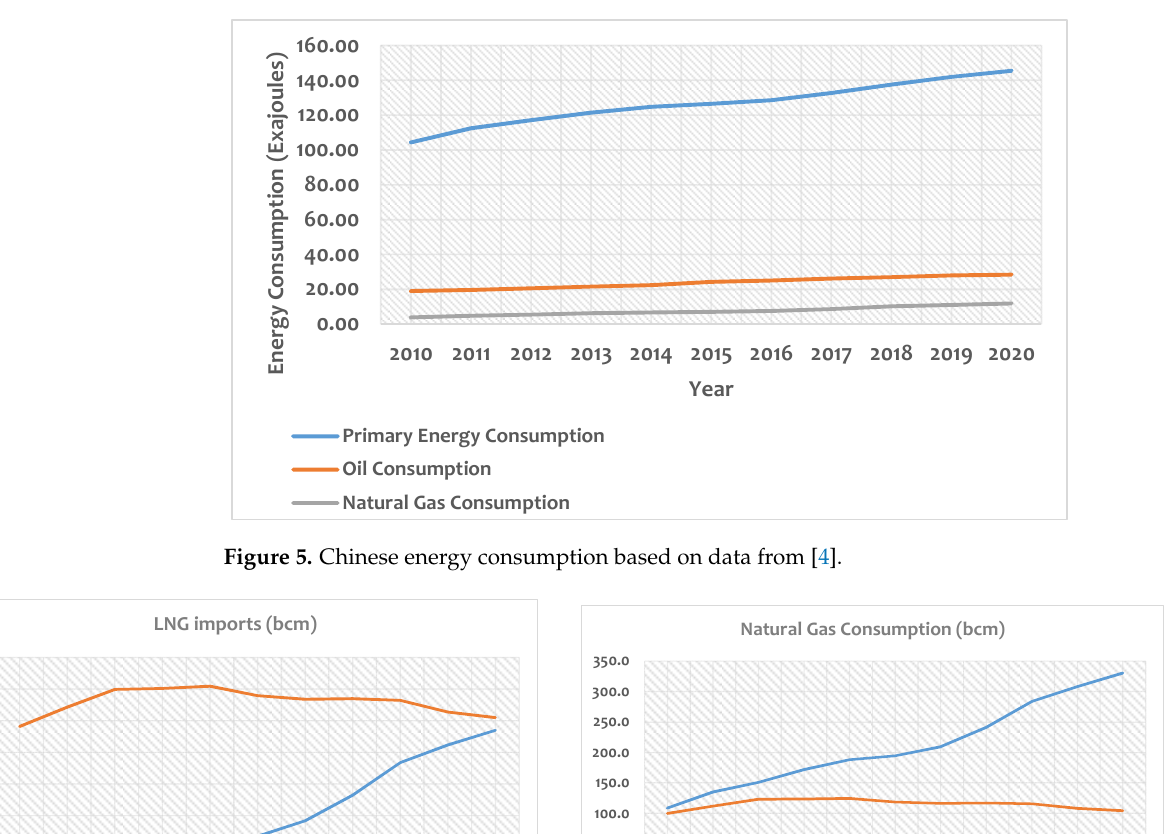
Figure 5. Chinese energy consumption based on data from [4].